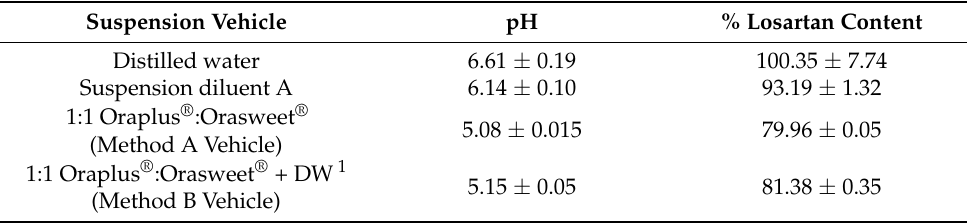
Table 1. pH and losartan content of losartan suspensions prepared using various suspension vehicles at t = 0. Data presented are the mean of n = 3 ±